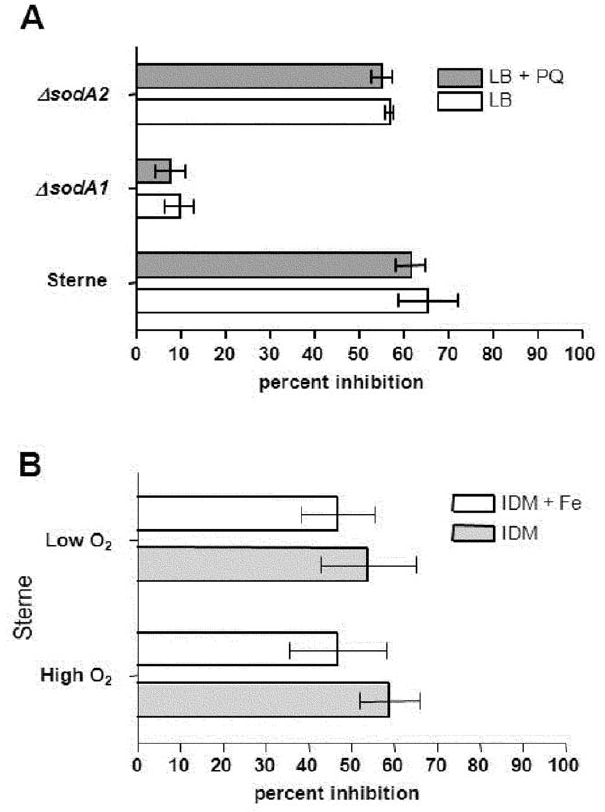
Figure 5. Nitroblue tetrazolium salt (NBT) assay of superoxide dismutase (SOD) activity from whole cell lysates of B.anthracis grown in various growth conditions. (A) Percent inhibition of superoxide production from 5 m g of whole cell lysates of B. anthracis Sterne 34F 2 , and the mutants D sodA1 and D sodA2 grown in LB (iron- rich) medium with and without the addition of a high concentration of paraquat (800 m M). (B) Percent inhibition of superoxide production from 5 m g of whole cell lysates of B. anthracis Sterne 34F 2 grown in IDM and IDM supplemented with 20 m M Fe(II)SO 4 N 7H 2 O under high and low aeration. Low O 2 indicates cultures grown in a 40% culture to flask volume/volume ratio with slow shaking (125 rpm); High O 2 indicates cultures grown in a 10% culture to flask volume/volume ratio with rigorous shaking (300 rpm). Percent inhibition indicates the amount by which the cell lysate inhibits NBT reduction relative to a non-lysate containing control reaction (see Materials and Methods).